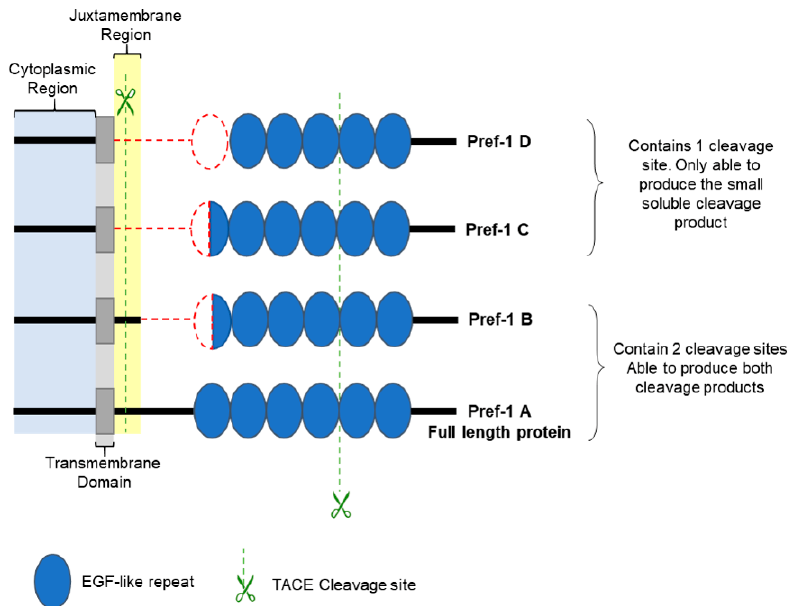
Figure 5. Structure of the di ff erent Pref-1 isoforms. The Pref-1 protein can be found in four isoforms (Pref-1 A, B, C and D) due to alternative splicing. The red dotted line indicates the missing sections due to in-frame deletions. Green arrows indicate the cleavage sites for the generation of the soluble forms of the protein. Pref-1, Preadipocyte factor 1; EGF, Epidermal growth factor. Image created by C.d.S.